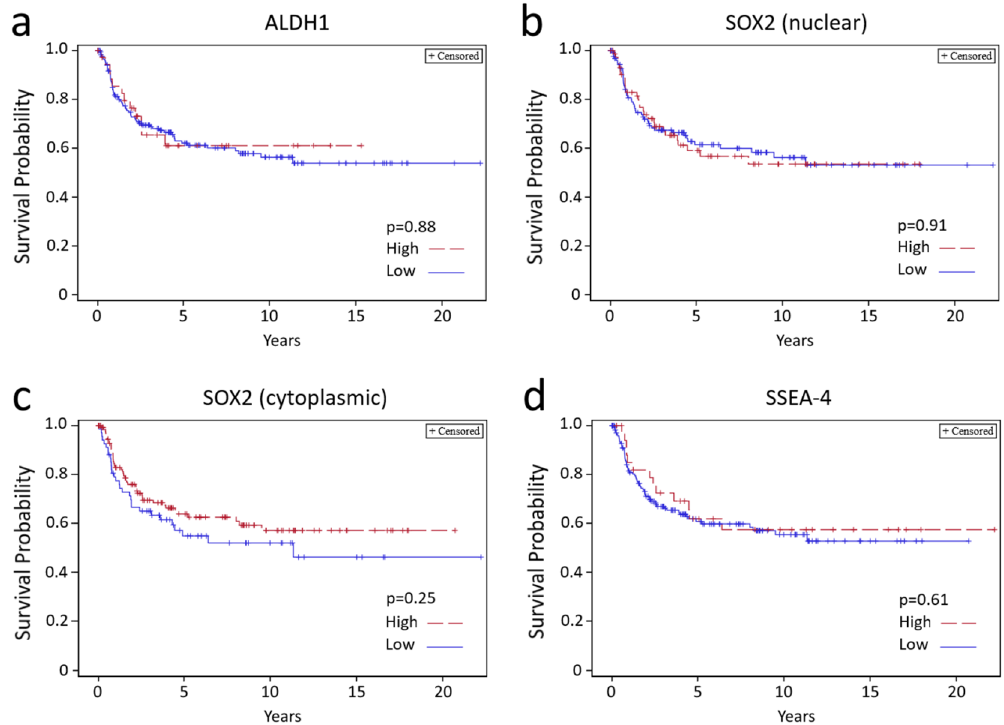
Figure 2. Kaplan–Meier survival analysis based on high (H-score ≥ 4) and low (H-score < 4) expression of ALDH1 ( a ), nuclear SOX2 ( b ), cytoplasmic SOX2 ( c ) and SSEA-4 ( d ) after RC in the RC-only